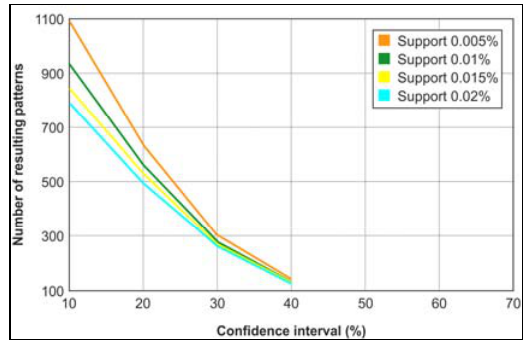
Figure 5. Performance comparison of different values for the CARMA parameters(“support” and “confidence”)